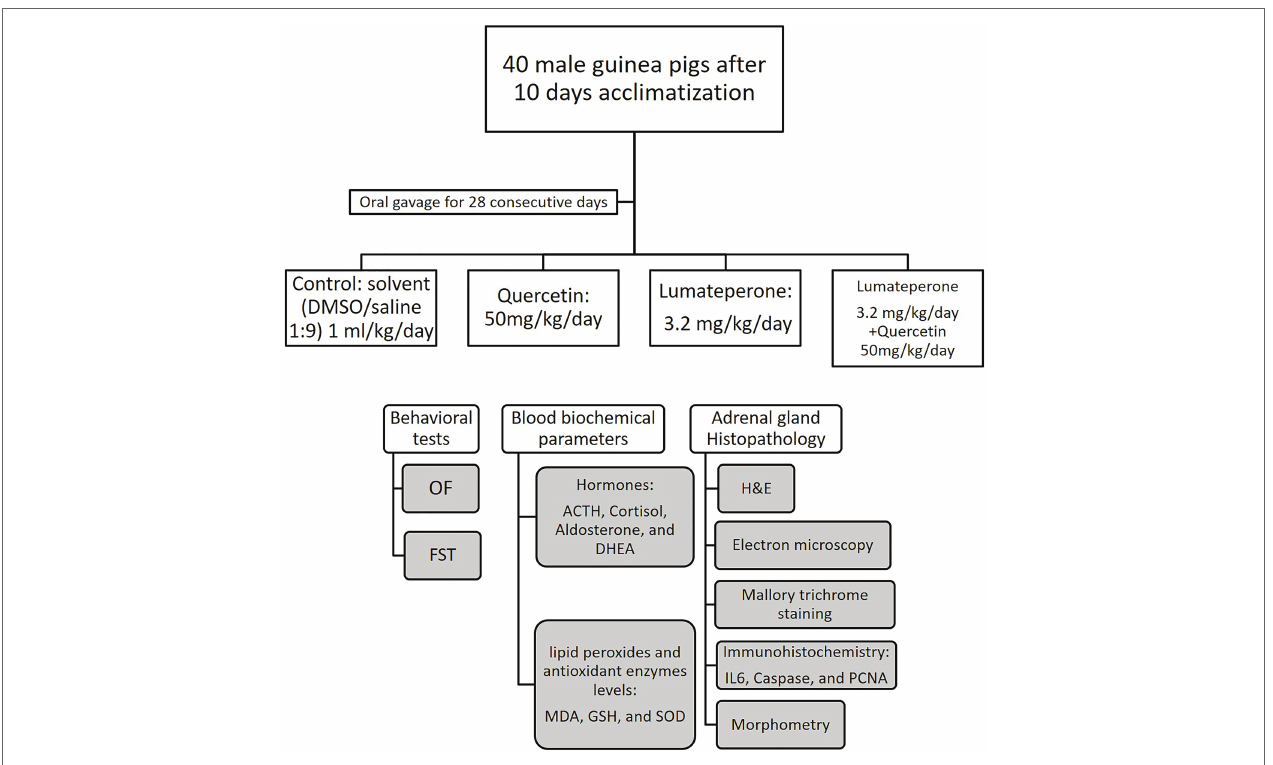
FIGURE 1 | Study design diagram illustrating the groups of animals and the behavioral, biochemical, and histopathological tests done. Open field (OF), forced swim test (FST), hematoxylin and eosin